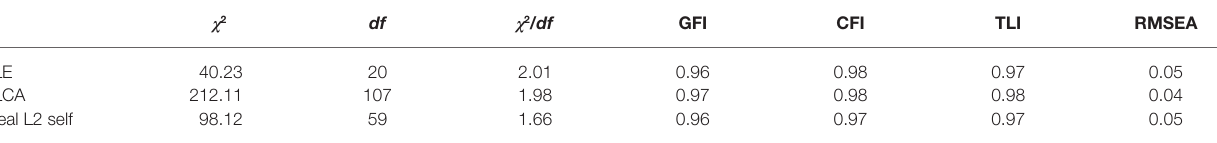
TABLE 1 | Fit indices of the measurement models.